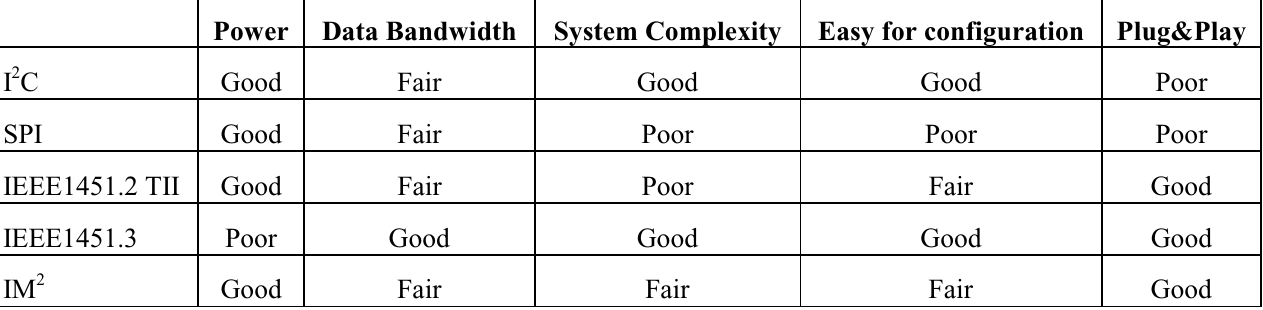
Table 2. Summary and comparison of sensor bus features.